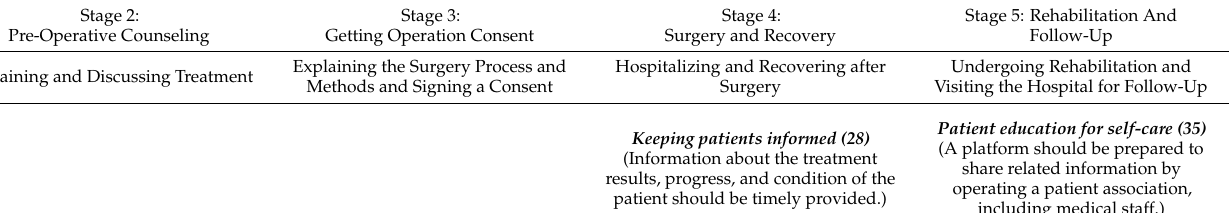
Table 3. The sample result of the workshop showing the importance of PE factors along the patient journey